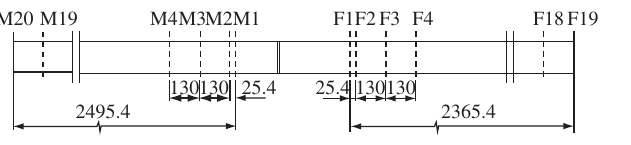
Figure 4. Measuring sections and strain gages mounting scheme.